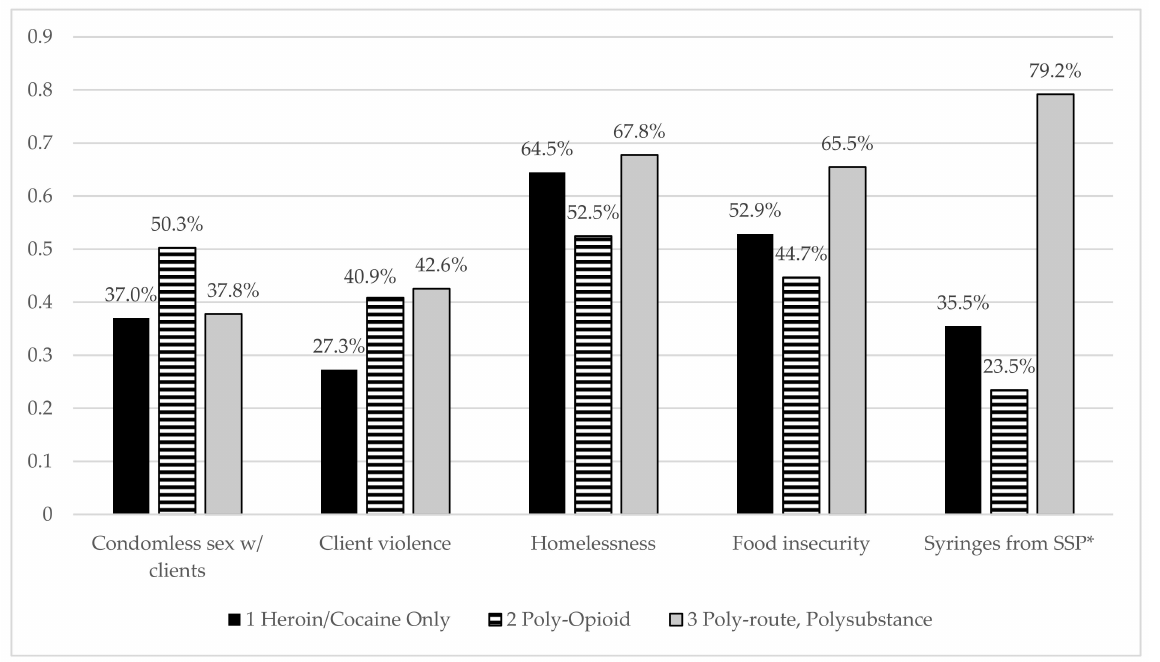
Figure 1. Prevalence of outcomes by substance use latent class, controlling for age and race; * Wald test significant at <0.05